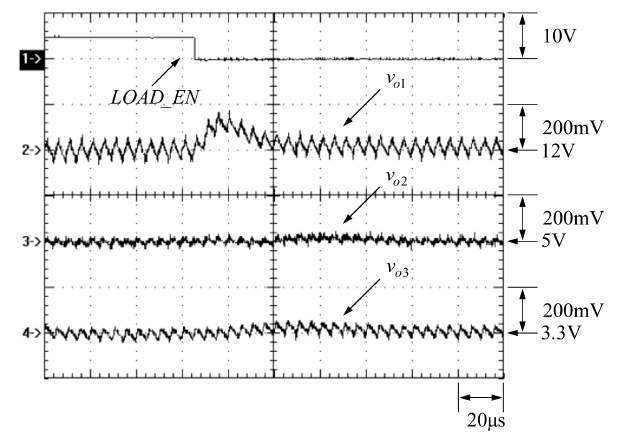
Figure 23. Dynamic response waveforms on condition that the main output load is changed from rated load to light load as the first and second secondary outputs are located at light load.